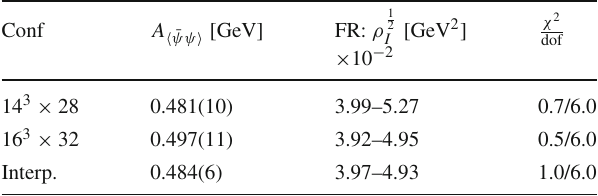
Table 17 The fitting results of the slope A (cid:5) ¯ ψψ (cid:6) obtained by the linear curves (cid:5) ¯ ψψ (cid:6) = − A (cid:5) ¯ ψψ (cid:6) x , ( x = ρ the lattice volumes V = 14 3 × 28 and V = 16 3 × 32 of β = 6 .